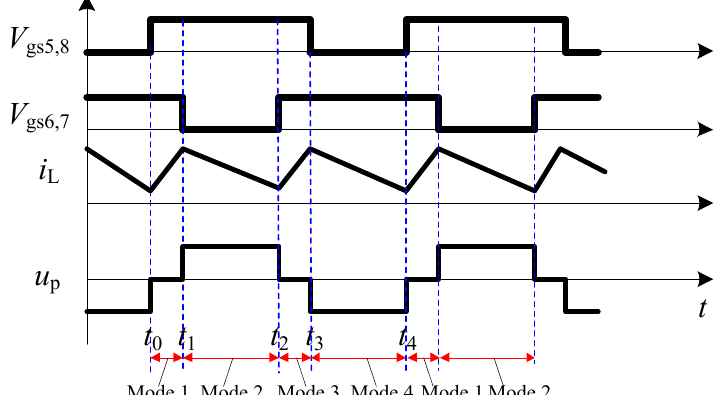
Figure 11. Operational principle of BSS-FBC in charging mode.